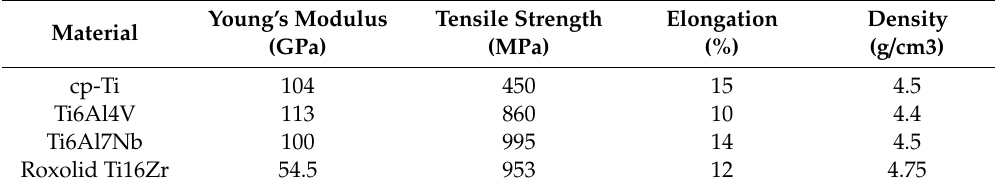
Table 1. Mechanical properties of Ti and Ti-based alloys (adapted from [8,16,18,20]).